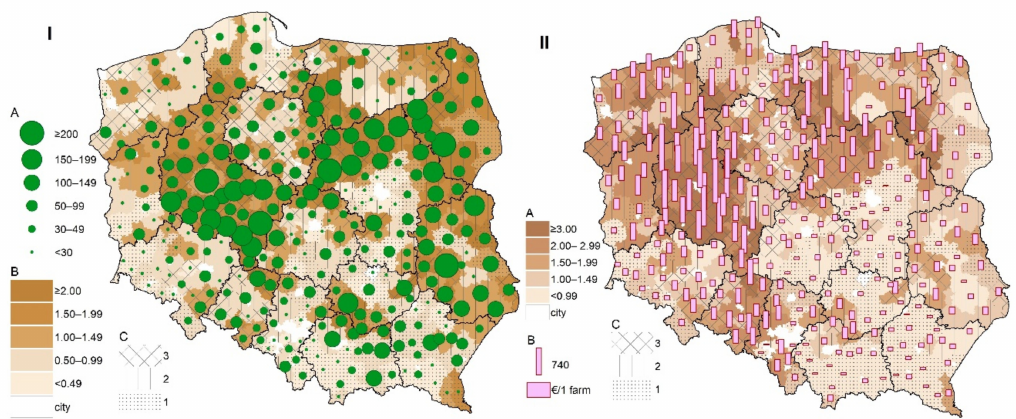
Figure 3. Measure of “Diversification into non-agricultural activities”. ( I ) Number of applications: total (A), per 1000 in- habitants (B); ( II ) per 100 farms (A) and amount from 1 farm (B); C—agricultural conditions: (1) low; (2) average; (3) high; Source: own study based on data from ARMA and LDB CSO,